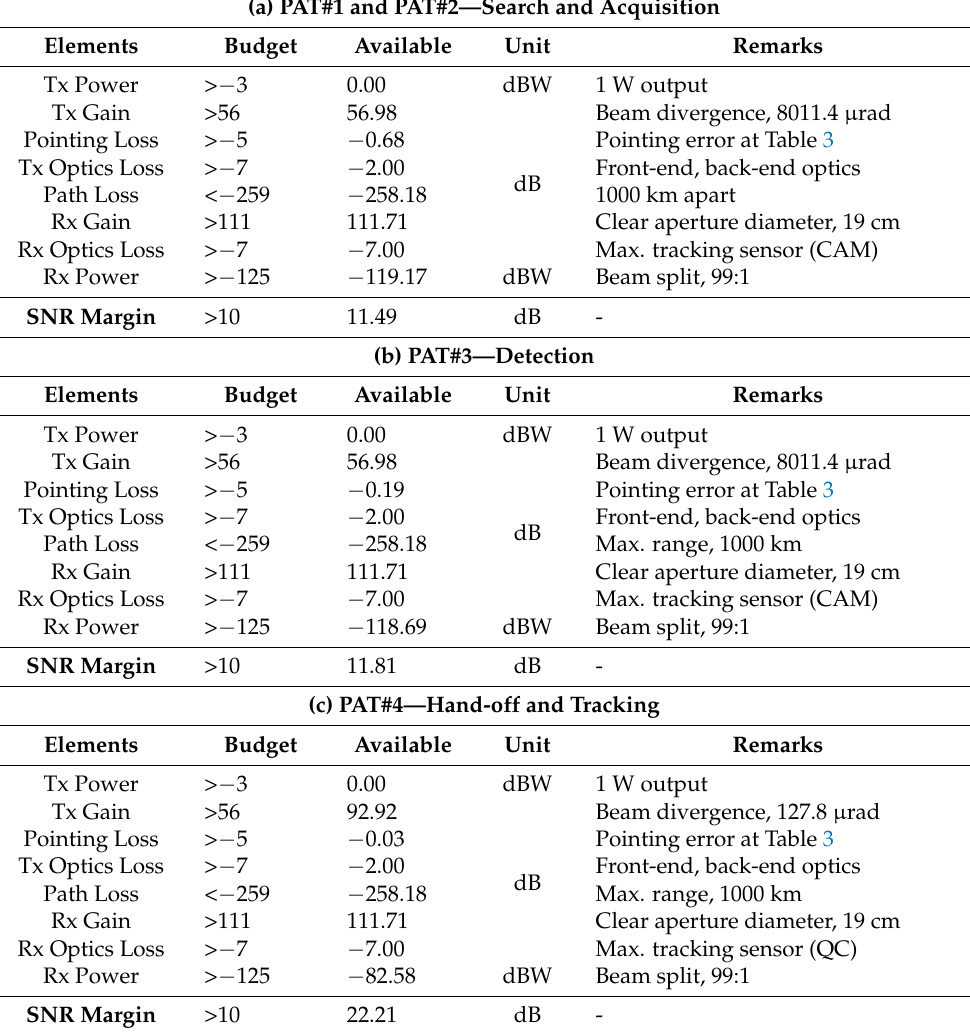
Table 4. Optical link budget and SNR margin for each PAT sequence in 1000 km of